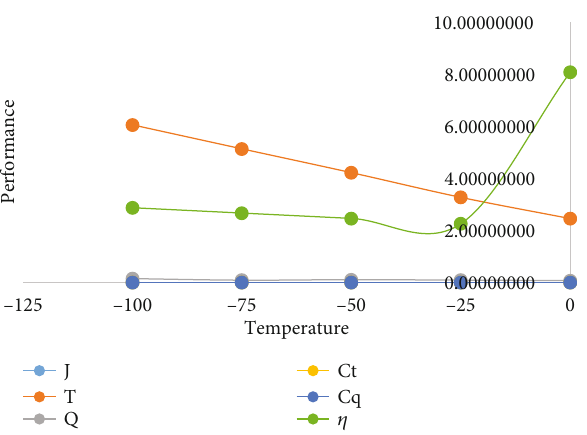
Figure 31: Performance in fl uencing parameters of Design-3.